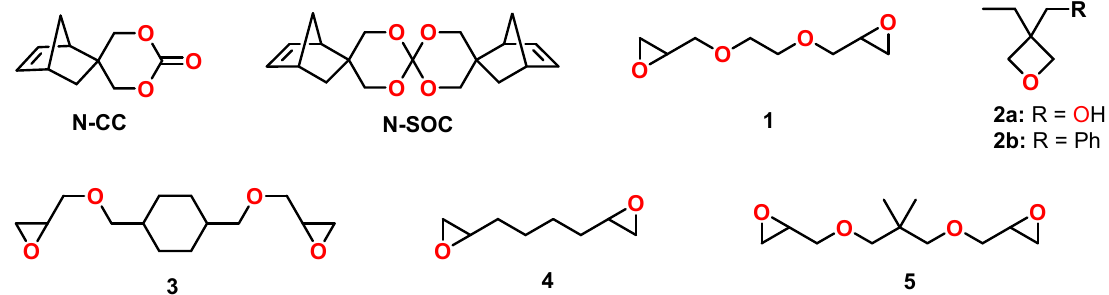
Figure 20. Chemical structure of cyclic ether monomers used for copolymerization with the cyclic carbonate N-CC and the spiroorthocarbonate N-SOC.